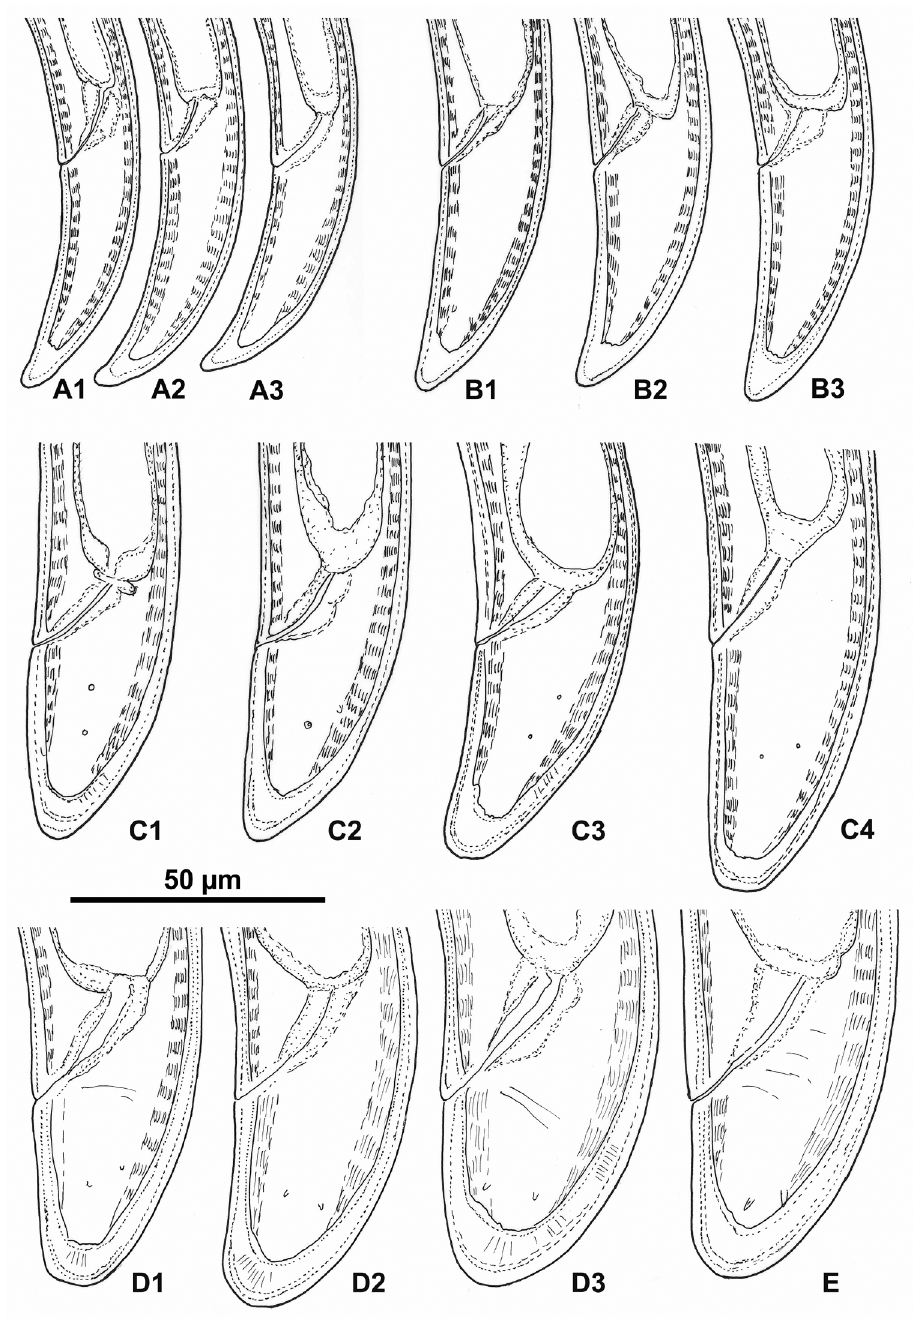
Figure 5. Longidorus piceicola Juveniles and female from Bran locality: Variations in tail shape of